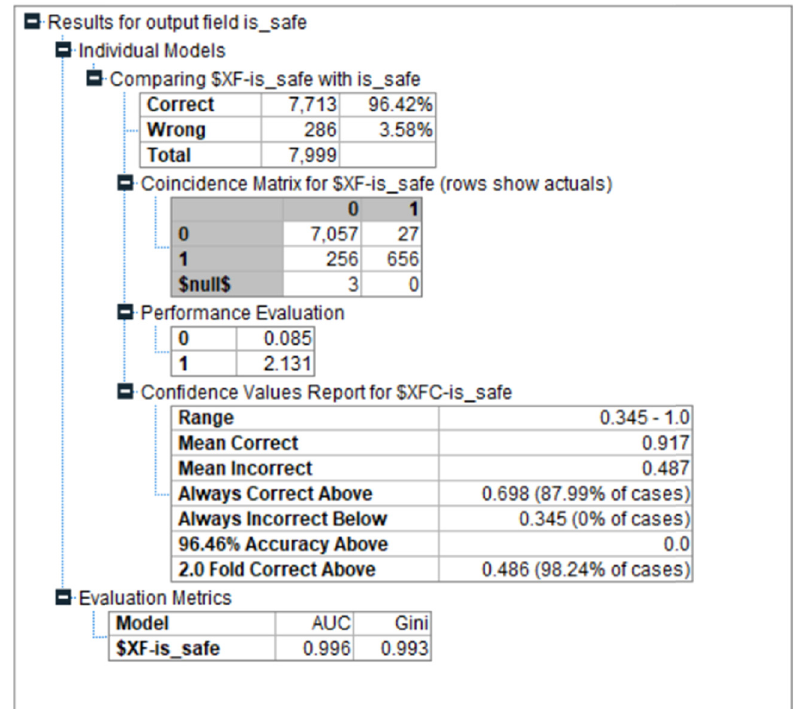
Figure 7: Accuracy level in proposed ensemble model.